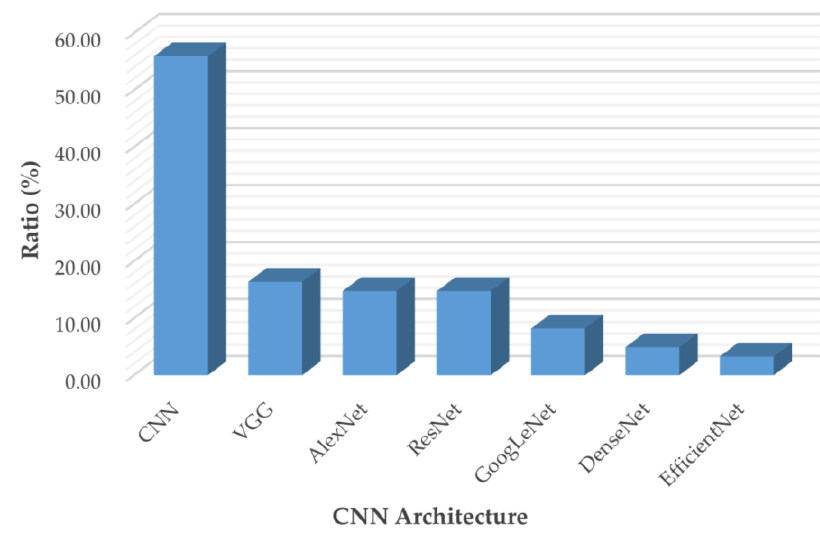
Figure 6. Usage of state-of-the-art CNN models from 2015 and 2022. AlexNet [85] came out in 2012 and was a revolutionary advancement in deep learn- ing; it improved traditional CNNs by introducing a composition of consecutively stacked